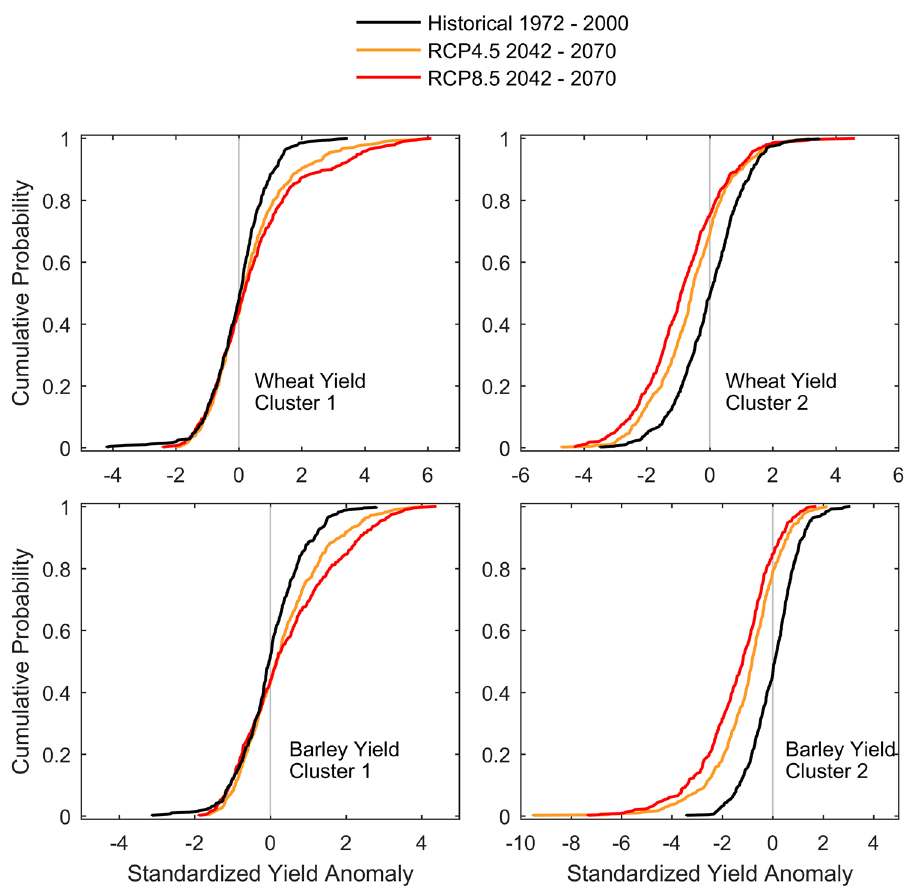
Figure 5. Pooled wheat (top) and barley (bottom) yield anomalies using RCP4.5 (orange) and RCP8.5 (red) for the 2042–2070 period in relation to the historical (1972–2000; black line). Yield was estimated using regression coefficients for individual GCM/RCM